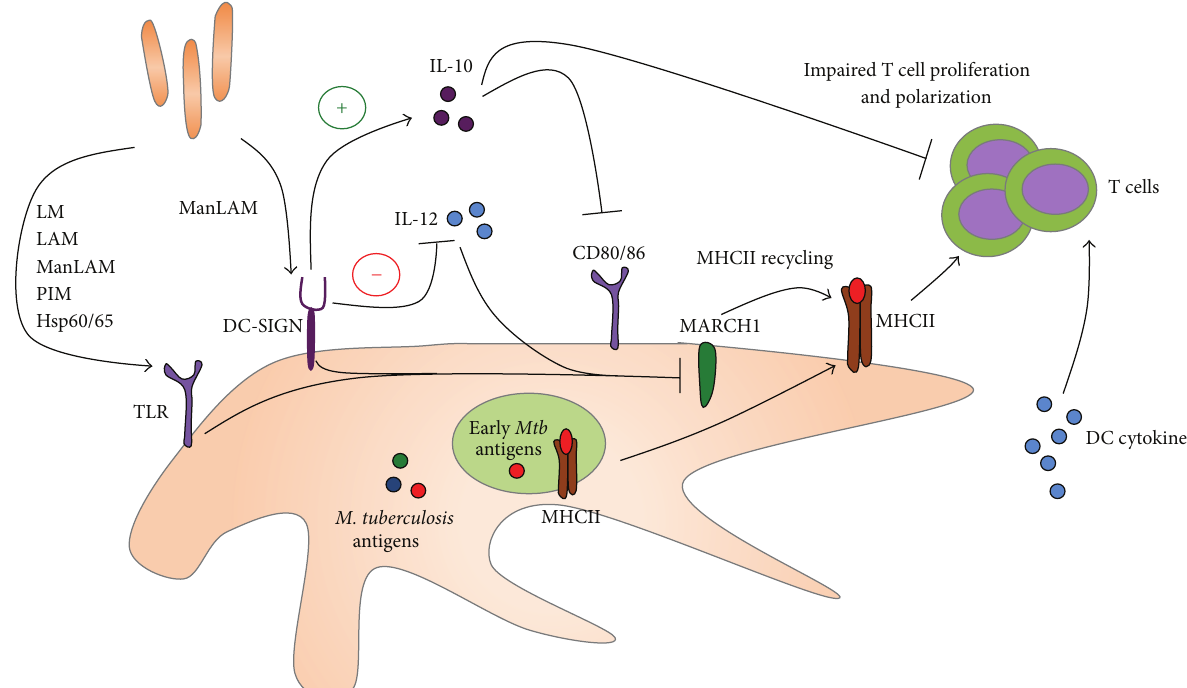
Figure 3: DCs are the primary antigen presenting cells (APCs) in the immune system and play a central role in activation and differentiation of T cells by presenting antigenic peptides. DCs recognize a variety of M. tuberculosis components directly primarily through TLRs and DC-SIGN. Mtb impacts DC maturation and CD80/CD86 expression via induction of the immunosuppressive IL-10 mediator. Furthermore, engagement of TLRs and DC-SIGN during Mtb infection downregulates MARCH1, a ubiquitin ligase critical for recycling of MHCII on the cell surface. Downregulation of MARCH1 early during infection may play a role in limiting the repertoire of presented Mtb antigens and narrows the adaptive immune response in human